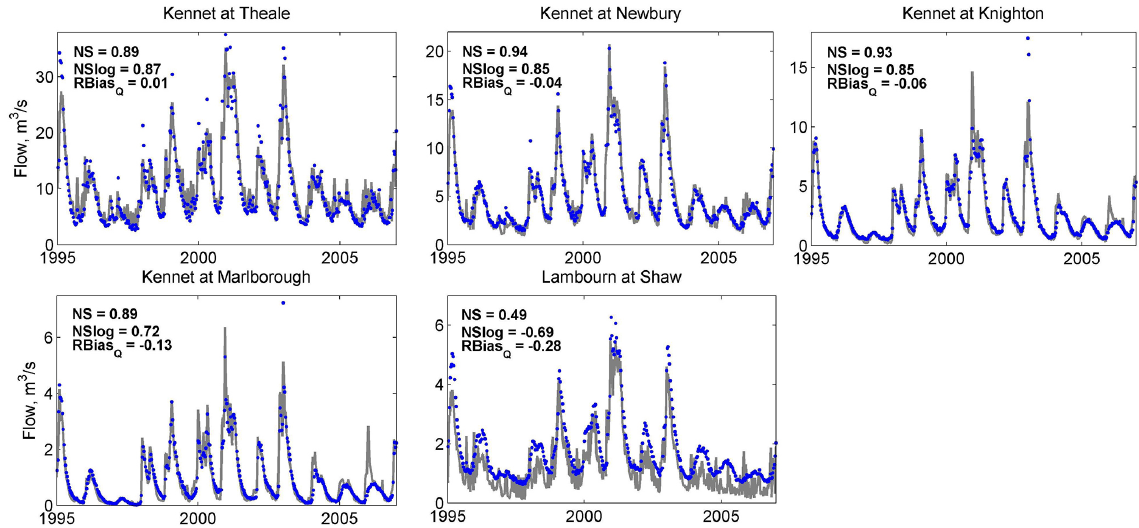
Figure 8. 10-day average flows at five gauging stations in the Kennet generated by the JULES + WG + PDM + CHALK + GWadj model configuration. Grey lines denote simulated flows, and blue dots are